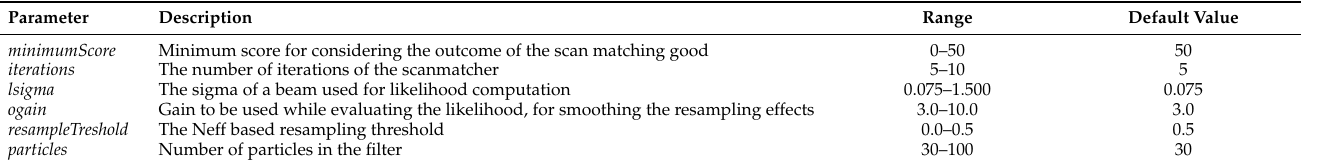
Table 2. List of Gmapping